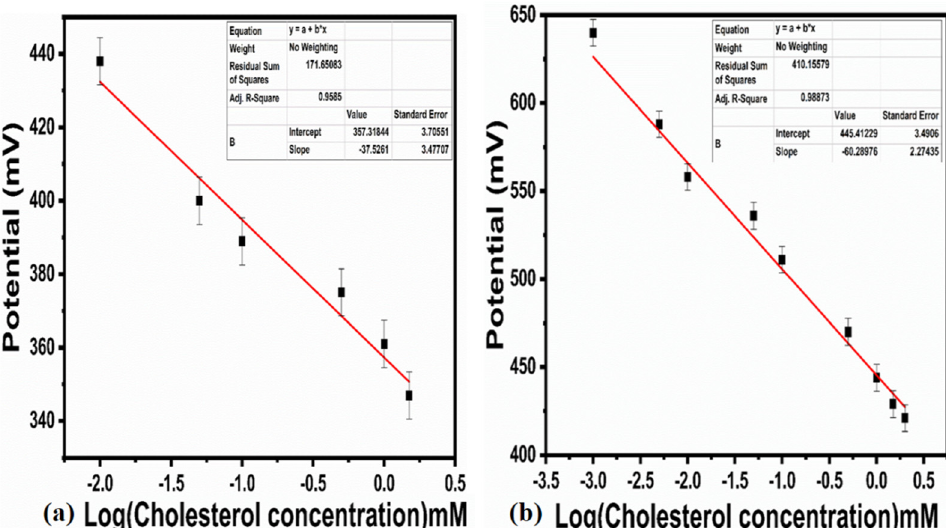
Figure 4. ( a ) Potentiometric response of cholesterol oxidase-immobilized pure Co 3 O 4 platelets and ( b ) cholesterol oxidase-immobilized Co 3 O 4 nanocrystals in 10 mM phosphate buffer solution of pH 7.3.